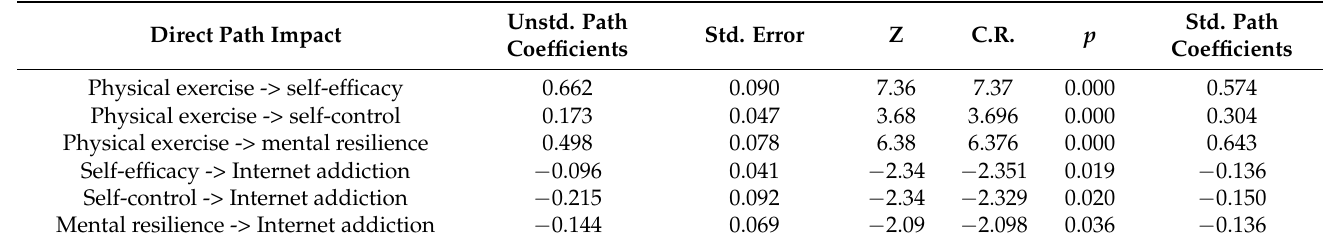
Figure 2. Structural equation model of physical exercise and Internet addiction. Table 3. Results of the path